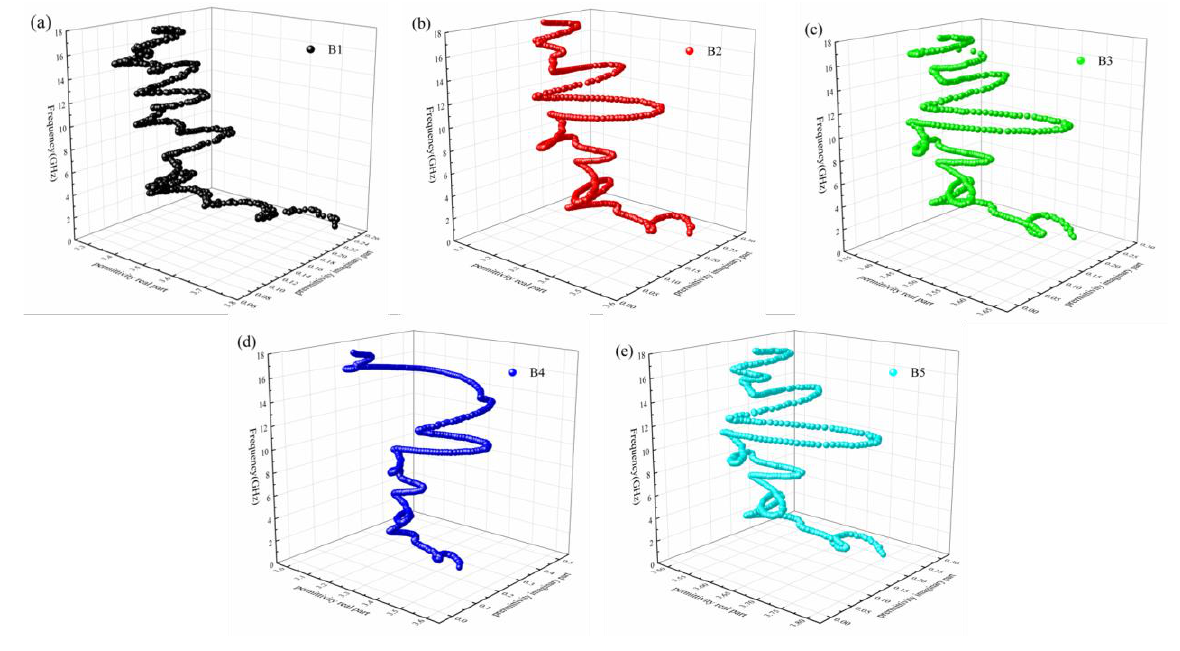
Figure 8. The Cole-Cole curves of paraffin composites B1 ( a ), B2 ( b ), B3 ( c ), B4 ( d ), and B5 ( e